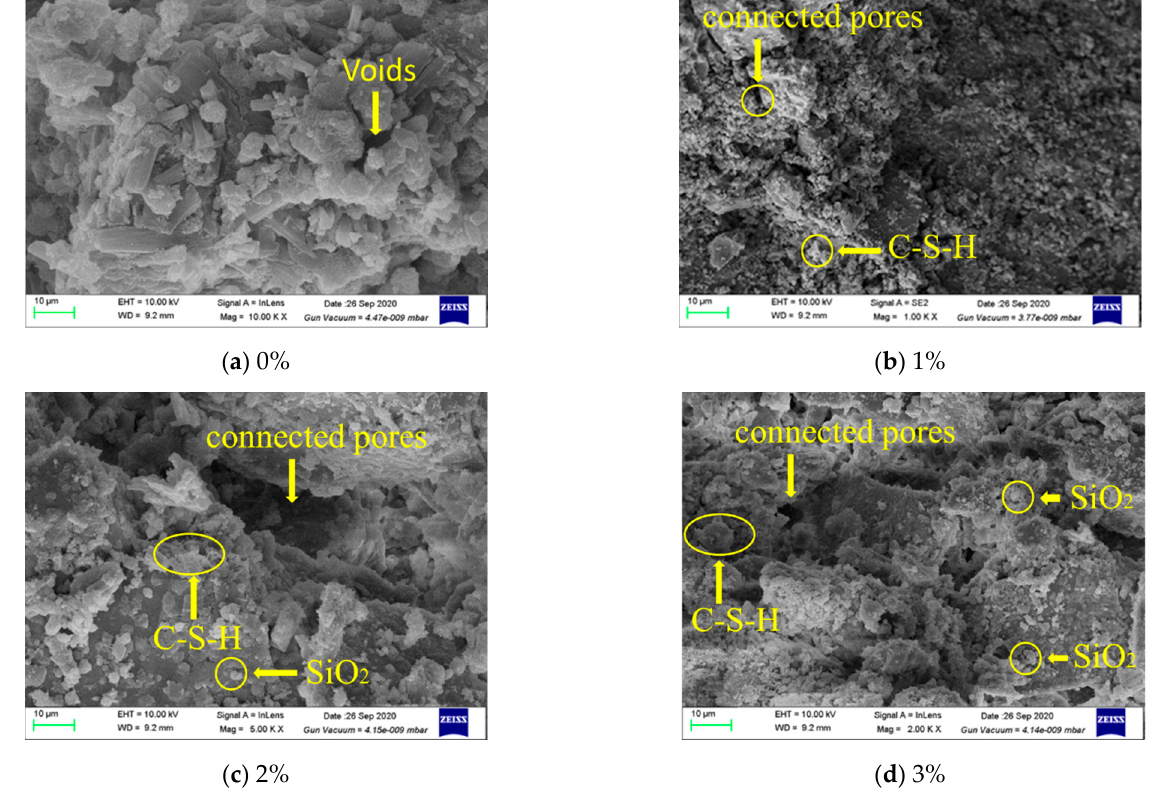
Figure 8. SEM images of the microstructure of recycled concrete with different NS contents. Figure 9a,b are the SEM scanning results of the microstructure of NS-recycled con- crete mixing with PVA fibers. With the incorporation of PVA fibers into the cementitious material, the microstructure of the material appears as a network structure. As the NS content increases, the network structure of reinforced C–S–H and PVA fibers tend to grow denser. When PVA fibers are incorporated, the PVA fibers and NS will work together, resulting in obvious ettringite (AFt) crystals. NS particles and PVA fibers can be found in the sample matrix, and significant amounts of reinforced C-S-H is found in the interface transition zone, which indicates that NS particles and PVA fibers can be distributed in the interface transition zone of recycled aggregate concrete. Obvious micro-cracks are ob- served in the transition zone of the concrete interface with a width of several nanometers, which may be related to the NS entering the recycled aggregate. Figure 9c,d illustrate that the mix of NS with recycled aggregate concrete has greatly improved the compactness of the interface transition zone, and few large micro-cracks are present in the interface tran- sition zone. This proves that the incorporation of NS and PVA fibers can significantly en- hance the interface transition zone of recycled aggregate concrete. To a certain extent, this phenomenon explains how the addition of NS and PVA fibers enhance the compressive strength of recycled aggregate concrete.